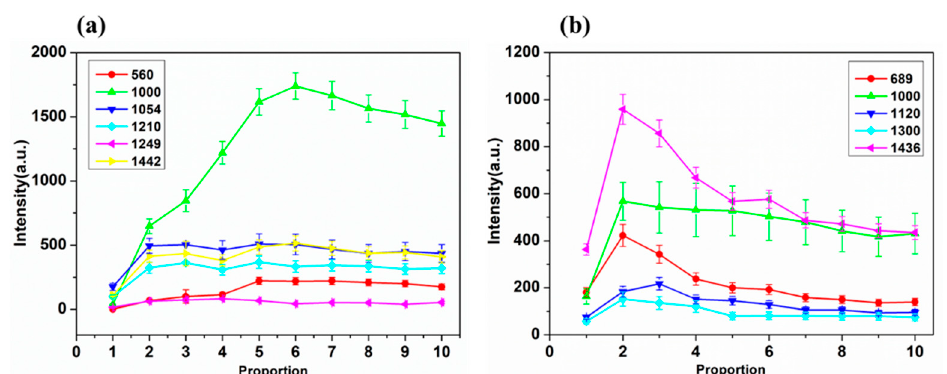
Figure 4. The signal intensity of DM and CBF with AuNPs at different ratios. ( a ) The signal intensity of DM at 560, 1000, 1054, 1210, 1249 and 1422 cm − 1 with AuNPs and DM at the ratio of 1:1 up to 10:1. ( b ) The signal intensity of CBF at 689, 1000, 1120, 1300 and 1436 cm − 1 with AuNPs and CBF at the ratio of 1:1 up to 10:1.